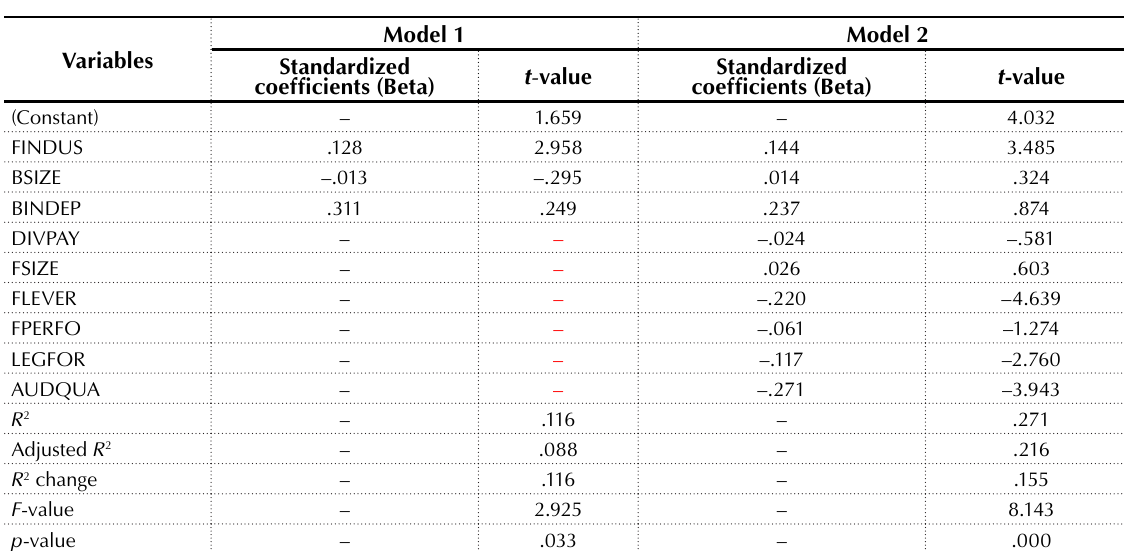
Table 5. Results of hierarchical regression